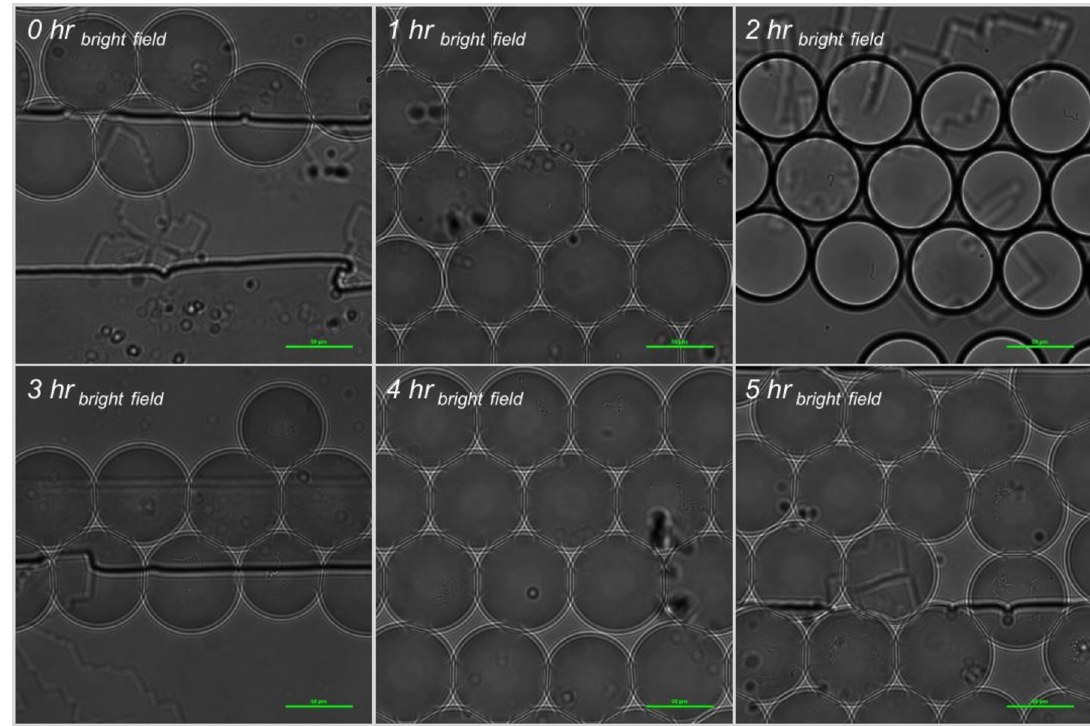
Fig 6. Bright field images of S . Typhimurium incubation in-droplet with sterile deionized water, and 10 μ g/ml FITC-Ab in 1x RV broth at 37˚C.